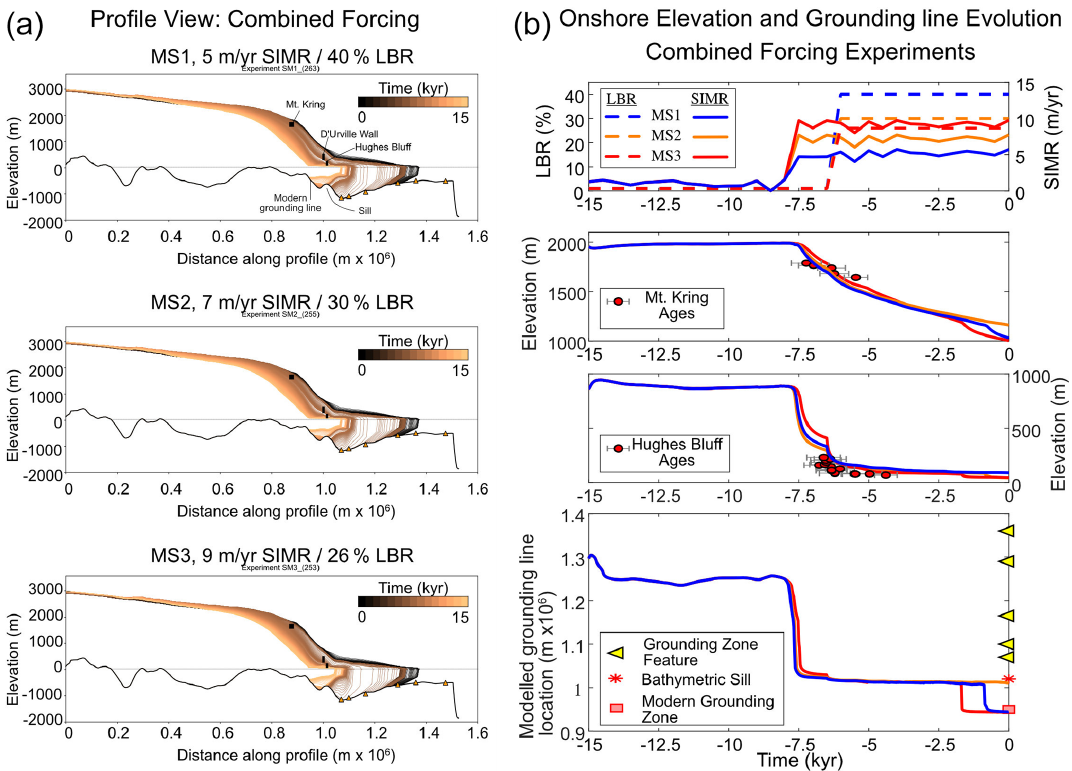
Figure 11. (a) Profile view: 15kyr evolution of modelled upper ice surface along flowline for combined forcing experiments. Black bars represent elevation range from three sites in this study. Orange triangles represent offshore features marking observed grounding zone wedges. (b) Onshore elevation and grounding-line evolution. Top subpanel: forcings applied (no relationship between LBR and SIMR). In SIMR cases, we varied the SIMR perturbation within a 0.5m/yr window at 500-year temporal frequency to simulate short-lived pulses of relatively warmer or cooler water mass changes. Top middle subpanel: time-transgressive elevation profile for Mt Kring with exposure ages; bottom middle subpanel: time-transgressive elevation profile for Hughes Bluff surface exposure ages; and lower subpanel: evolution of grounding-line position with modern grounding-line position, bathymetric sill at the mouth of David Fjord and mapped grounding zone features. We co-view exposure age data in these plots to allow generalised time-varying geometric relationships to be